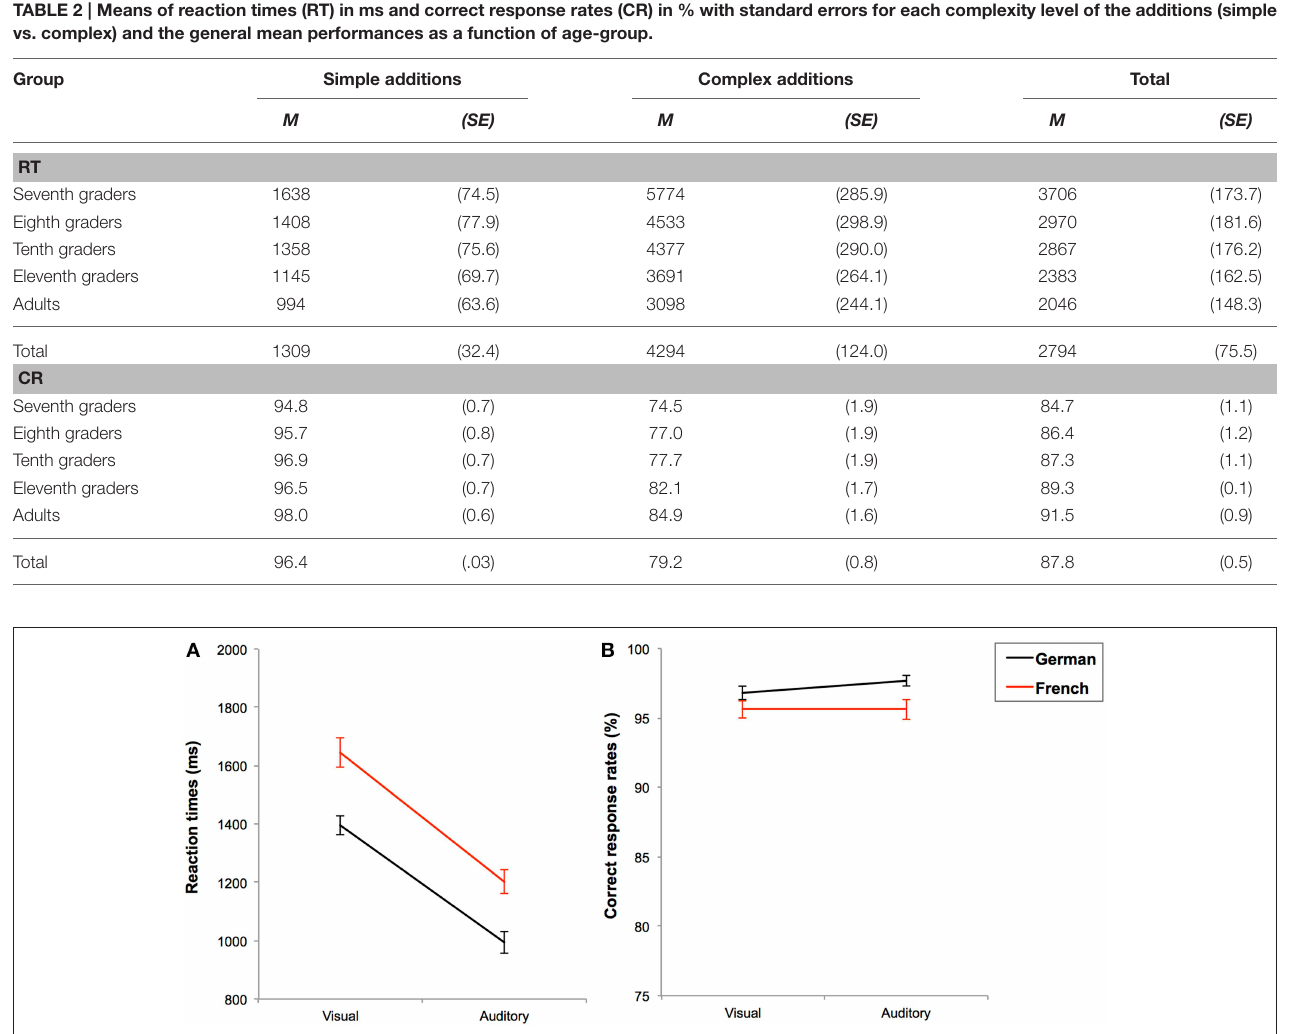
Frontiers in Psychology |